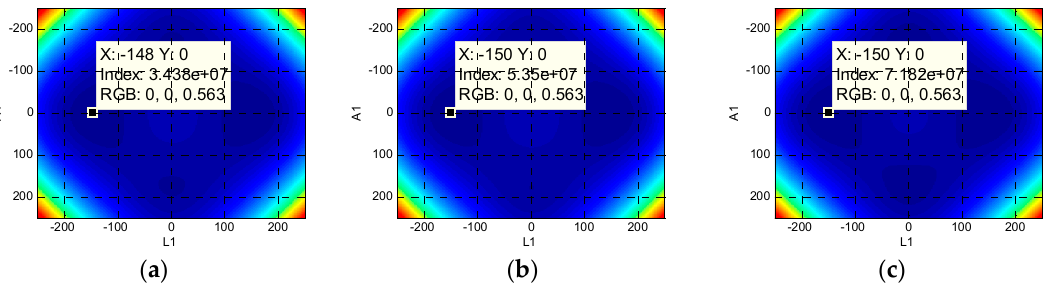
α and α . The 1 2